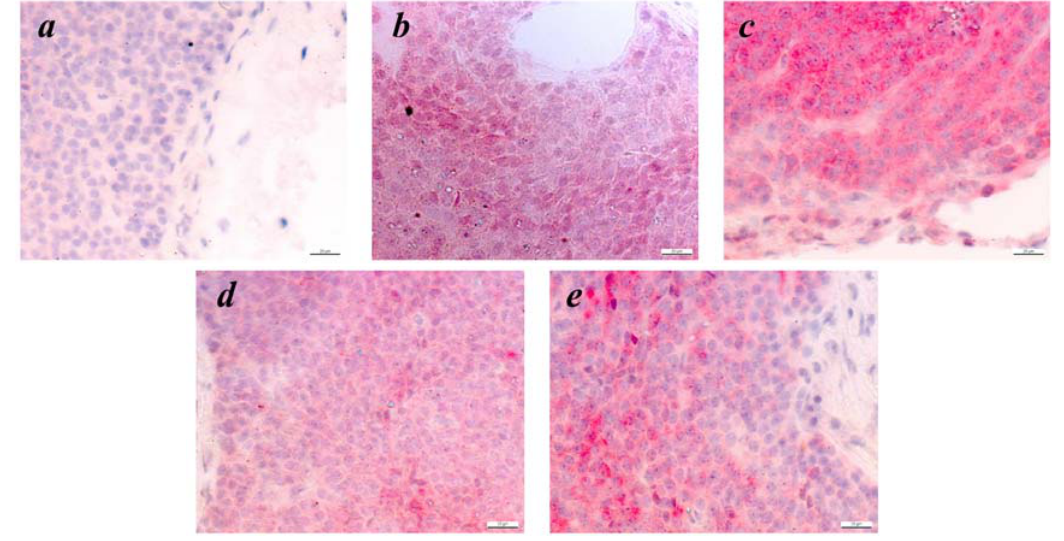
Figure 1. Expression of differentiation MAA in skin tumors of ret transgenic mice. Consecutive paraffin sections of mouse tumors (n = 20) were incubated with secondary Abs only (negative control, a ) or stained with rabbit anti-mouse polyclonal Abs against TRP-2 ( b ), gp100 ( c ), TRP-1 ( d ) or tyrosinase ( e ). Finally, sections were counterstained with haemalaun. Original magnification, ×400.